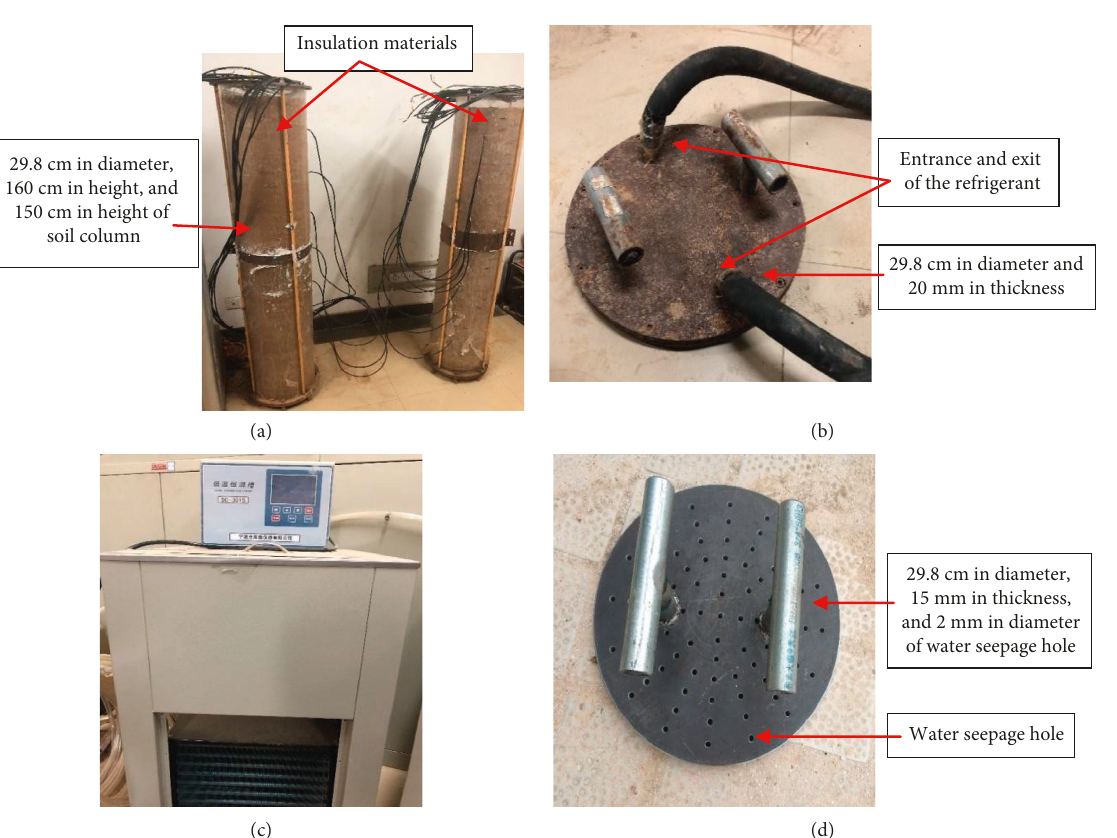
Figure 10: Diagram of the test equipment. (a) Plexiglass tube. (b) Cooling head. (c) Thermostatic bath. (d) Perforated